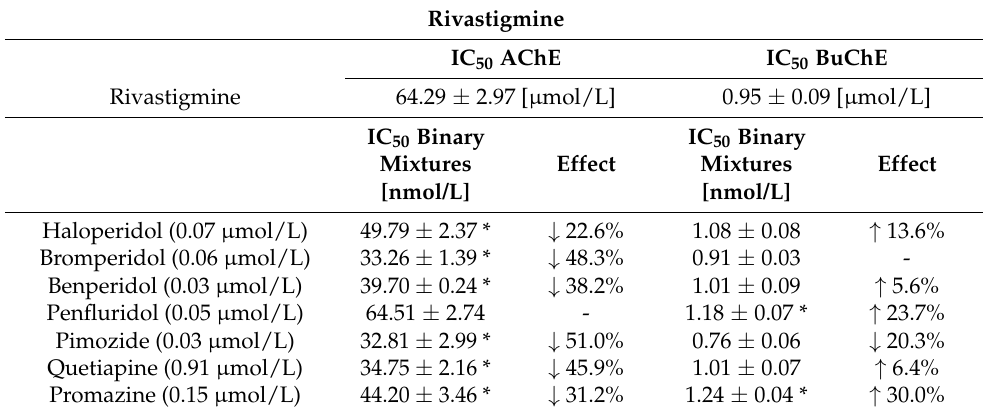
Table 4. Effects of antipsychotics on the anti-AChE and anti-BuChE properties of rivastigmine. Results are presented as mean ± SD, n = 6–9. * p < 0.05 vs. IC 50 of pure